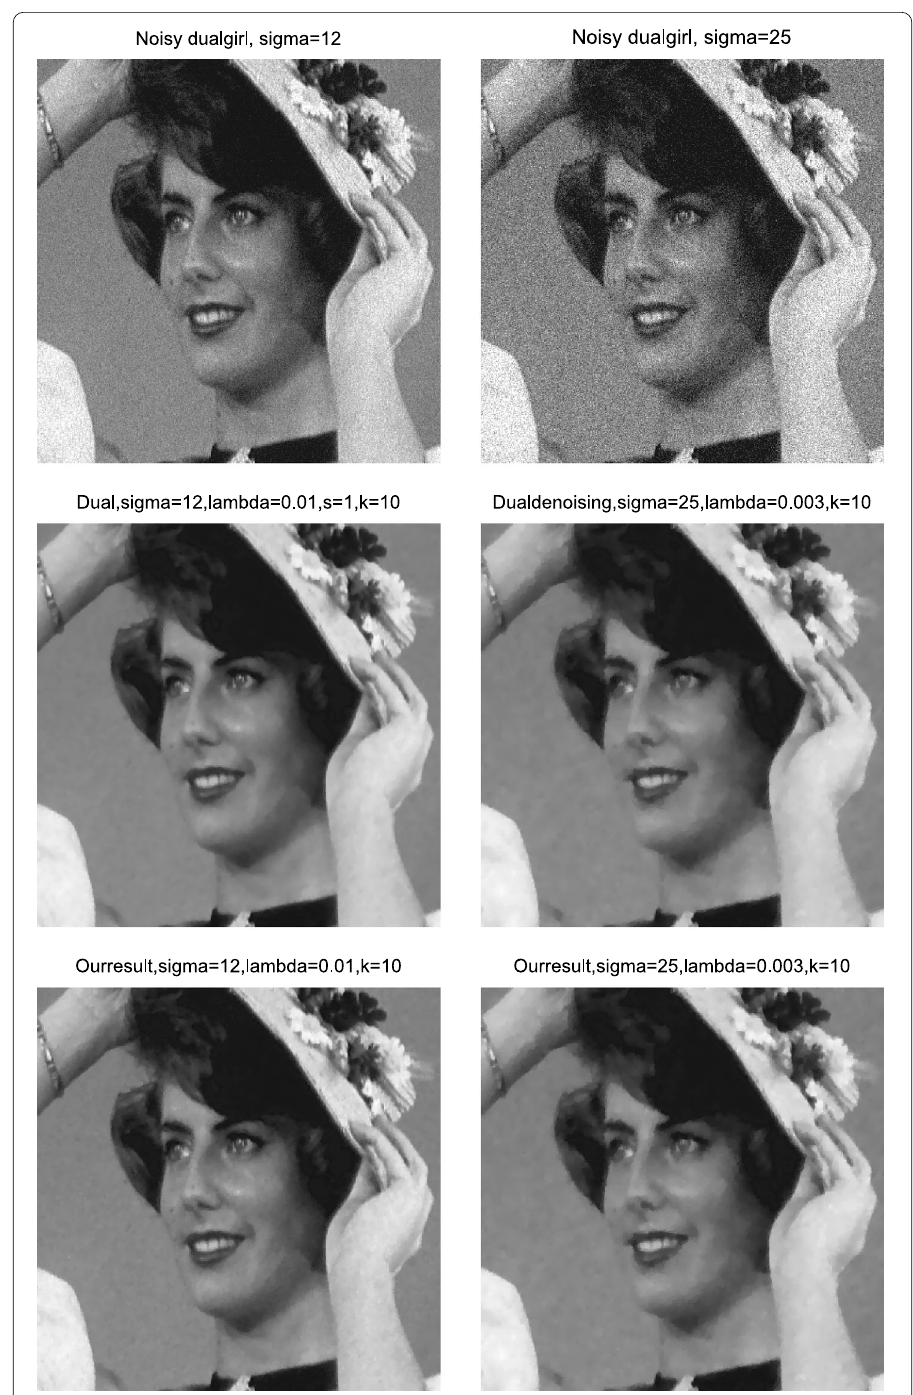
Figure 4 2-D denoising